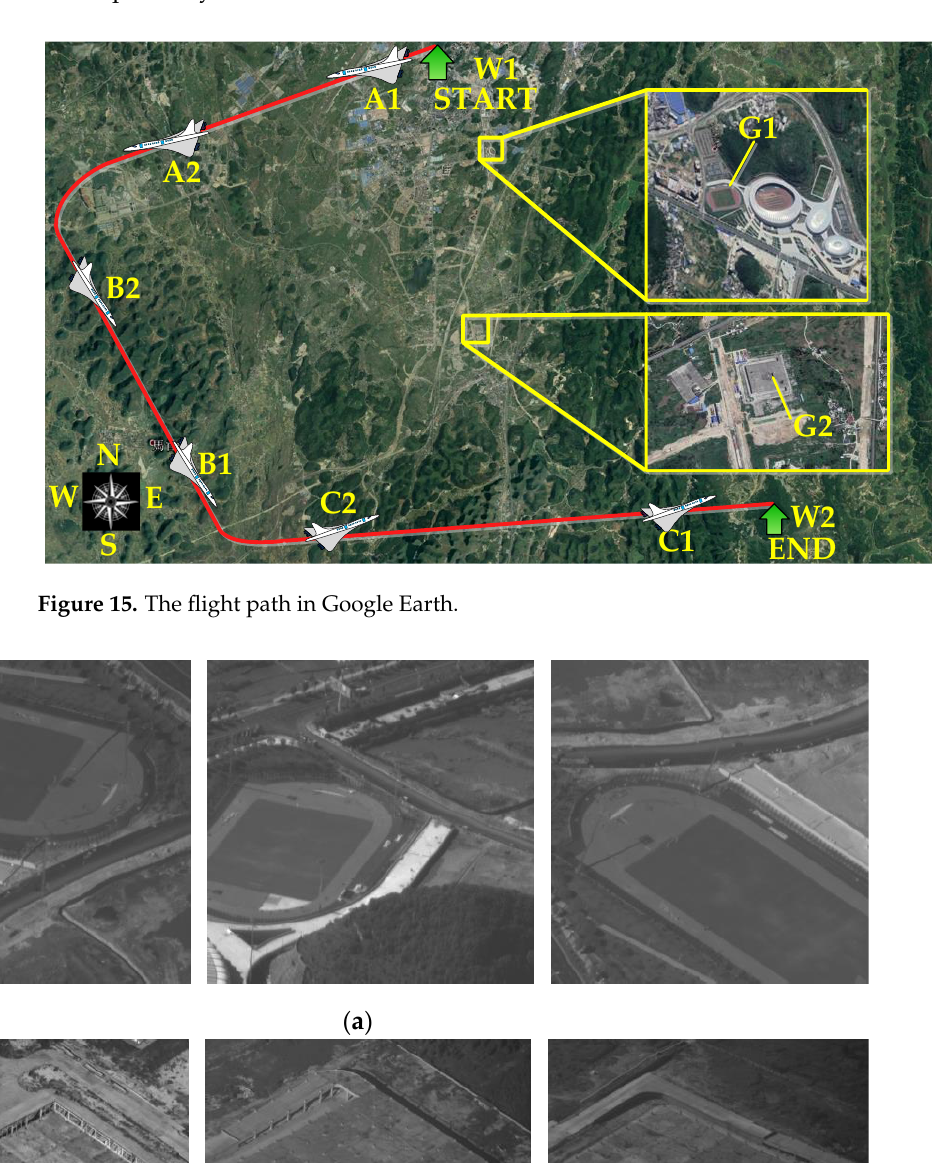
Figure 14. Photograph of the LRORS.